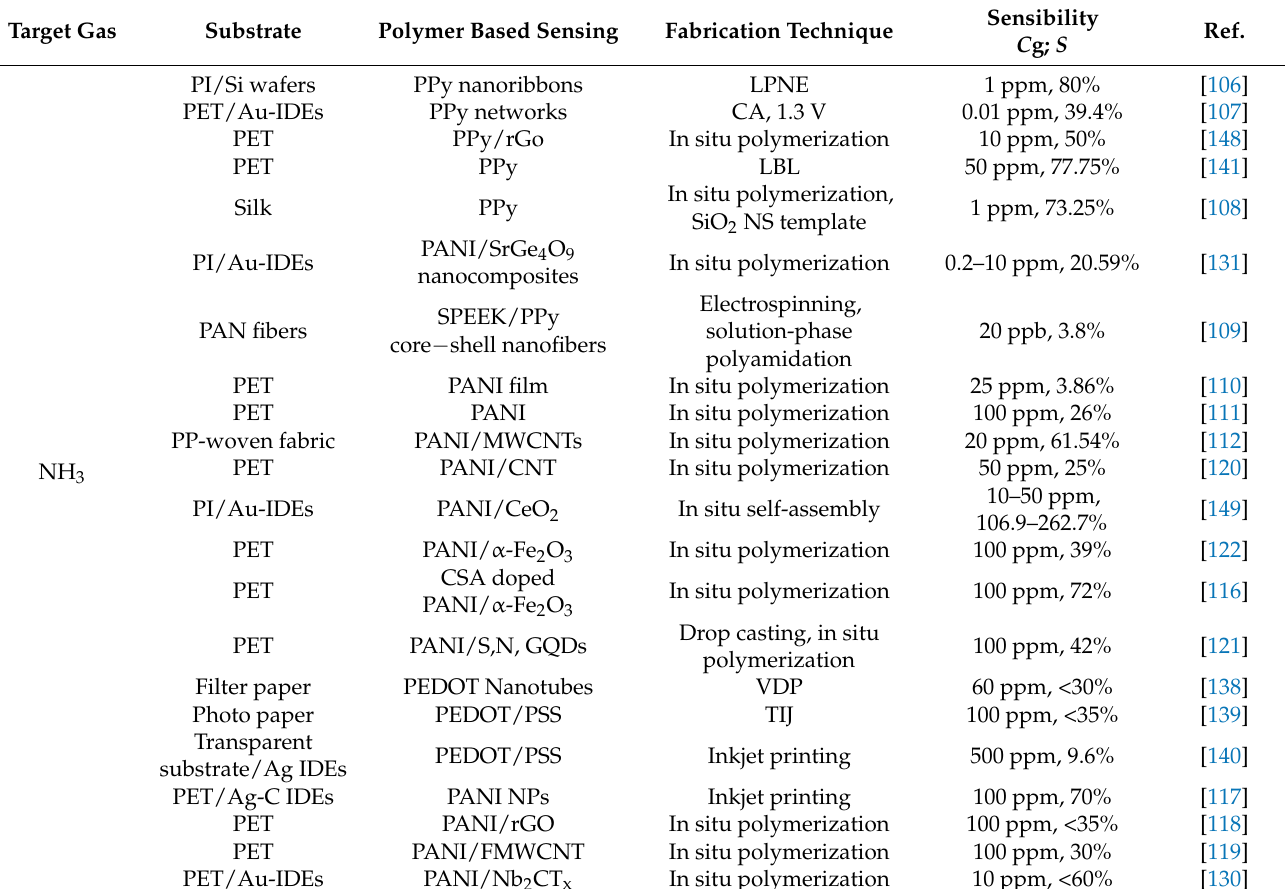
Table 2. Flexible gas sensors.